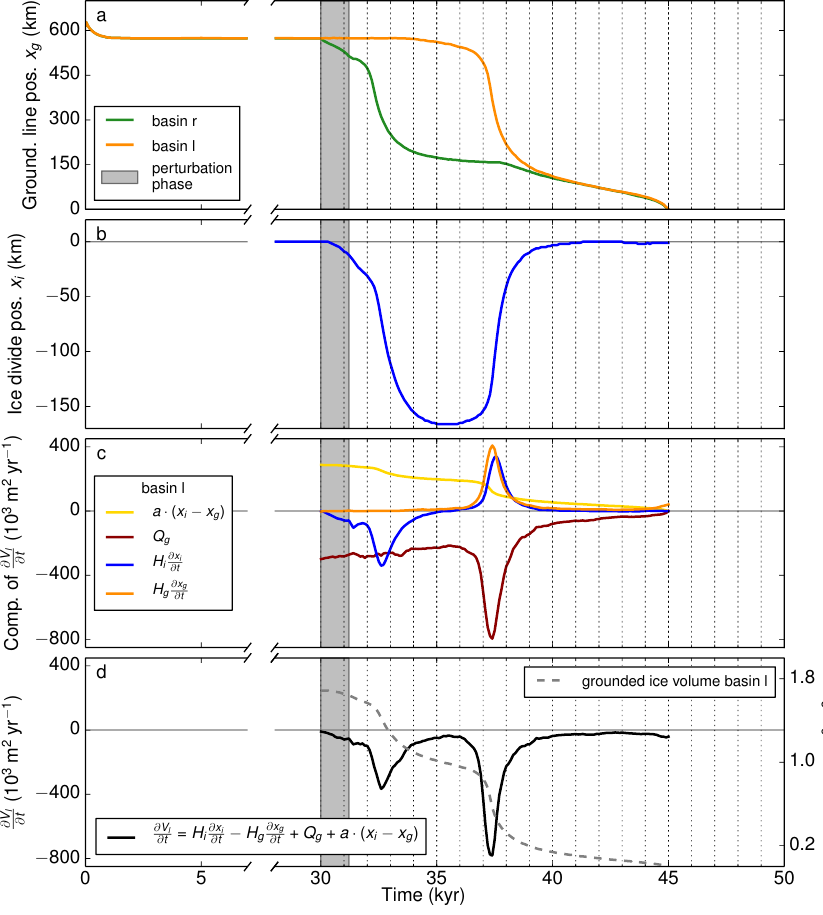
Figure 7. Same as Fig. 5 but here for the collapsing scenario C (simulation